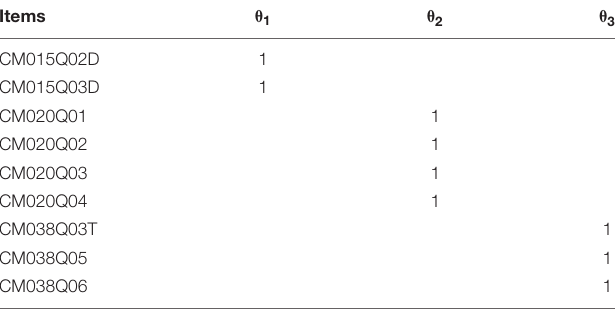
TABLE 1 | Q-Matrix for PISA 2012 released computer-based mathematics